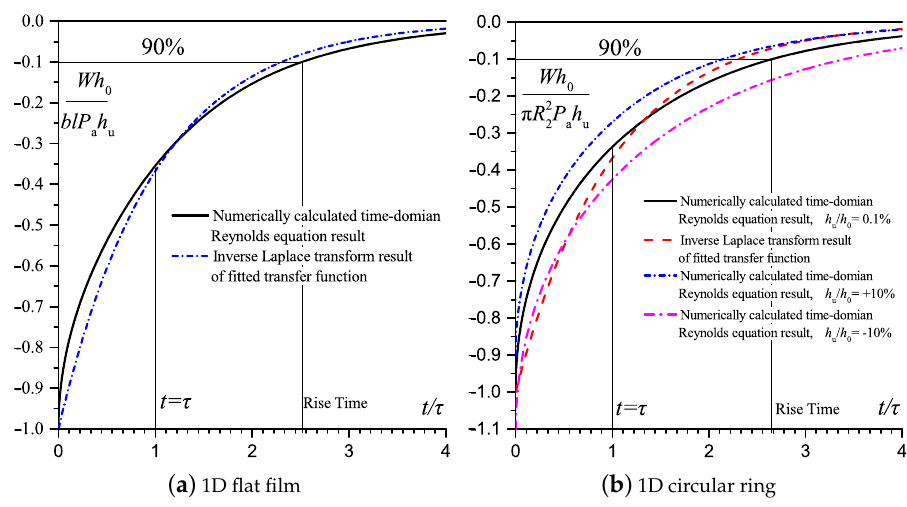
Figure 21. The time-domain response calculated by the FEM and obtained by inversely transforming the fitted